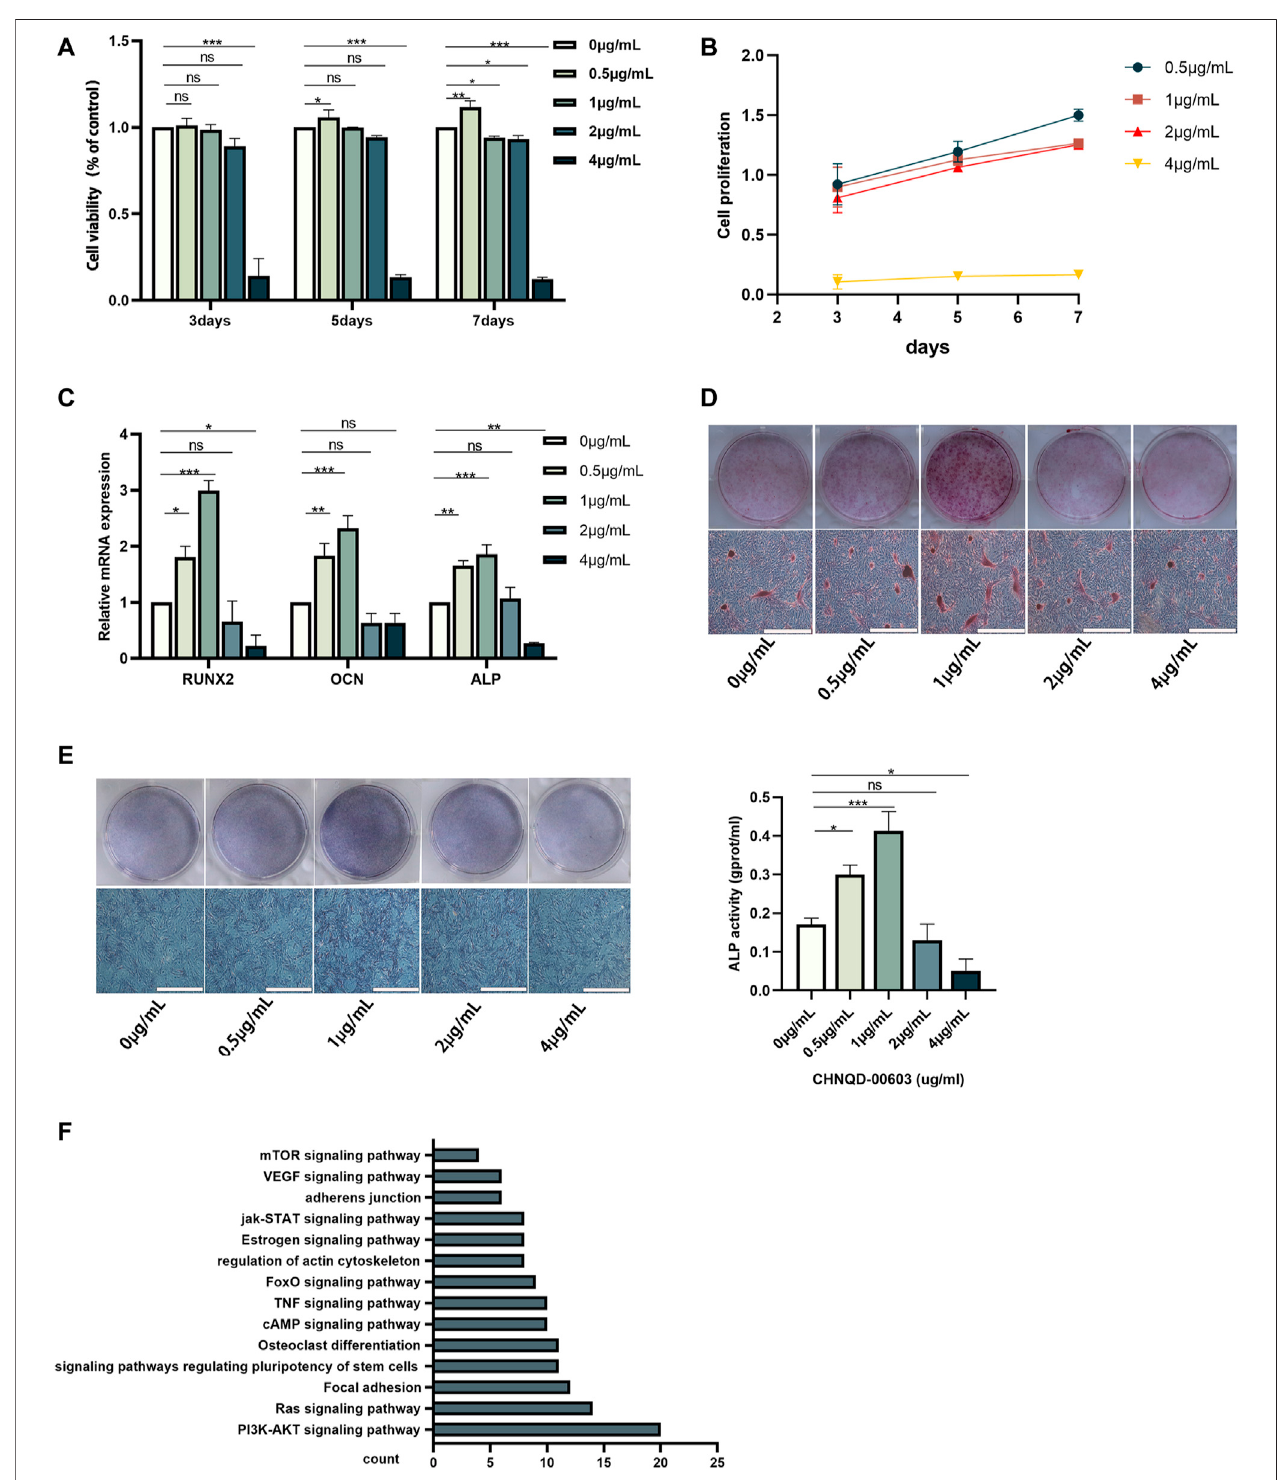
FIGURE3| TheeffectofdifferentconcentrationsofCHNQD-00603oncellviabilityandosteogenicdifferentiationofBMSCs. (A,B) CCK-8assaywasperformedto detect cell viability and cell proliferation of BMSCs cultured with different concentrations of CHNQD-00603 (0 µg/ml, 0.5 µg/ml, 1 µg/ml, 2 µg/ml, and 4 µg/ml) for 3, 5, and7 days (C) qRT-PCRtestedtheexpressionofosteogenesis-relatedgenesinCHNQD-00603-inducedBMSCsonday7. (D) AlizarinredSstainingindicatedcalcium salt deposits on day 14. (E) ALP staining and ALP activity were evaluated on day 7 (scale bar (cid:1) 200 μ m, scar bar (cid:1) 200 µm). (F) Bioinformatic analysisofpredicted target genes. Quantitative data are presented as the mean ± SD (n (cid:1) 3) (* p < 0.05, ** p < 0.01, *** p < 0.0001).